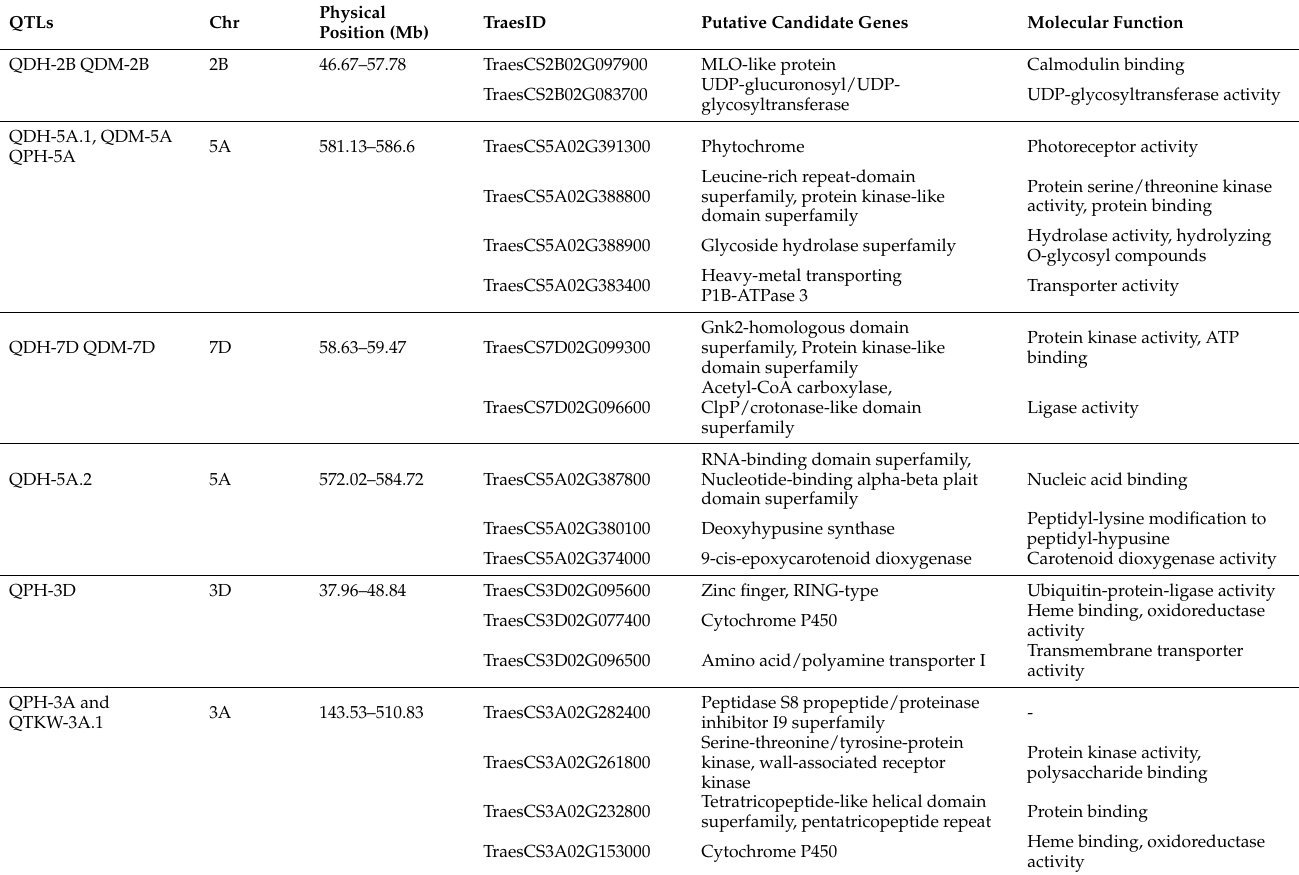
Table 6. Putative candidate genes governing the expression of DH, DM, PH, TKW and TW and their molecular